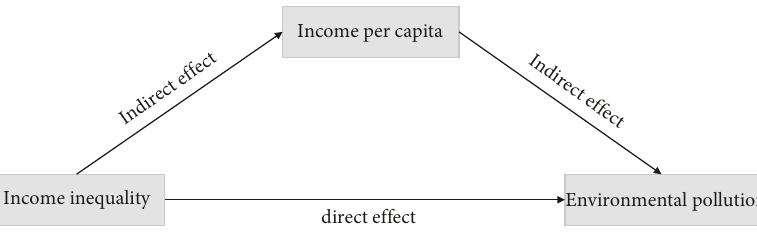
Figure 5: The impact mechanism of income inequality on environmental